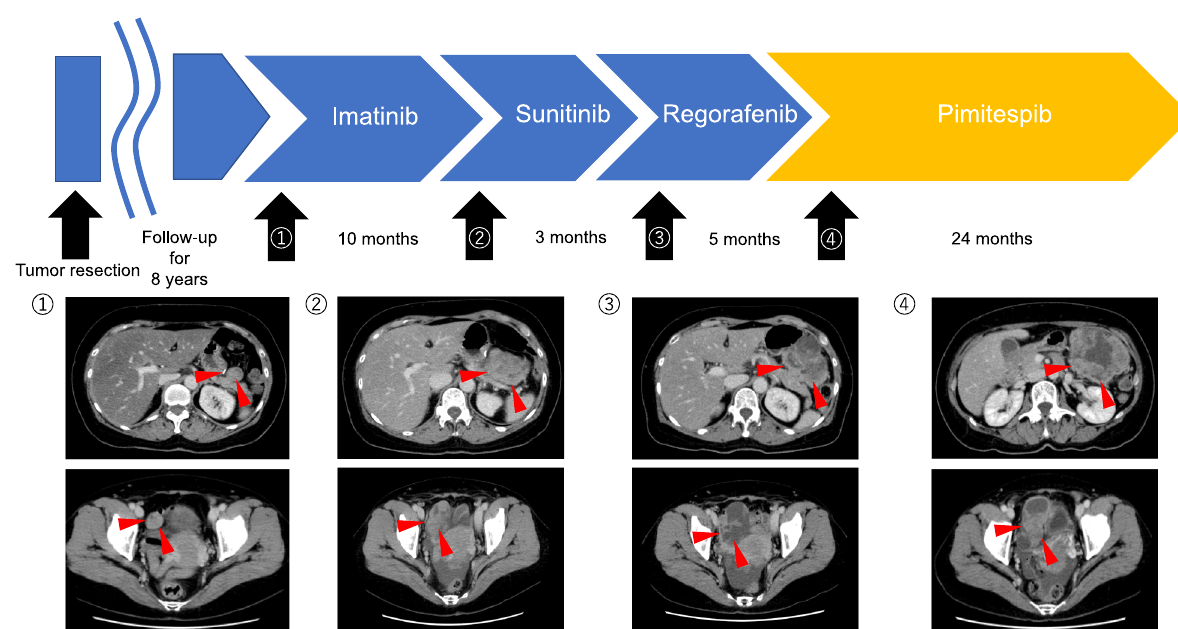
Fig. 2 Clinical course of treatments. Red arrowheads: recurrent peritoneal GISTs in the upper right abdomen and pelvic